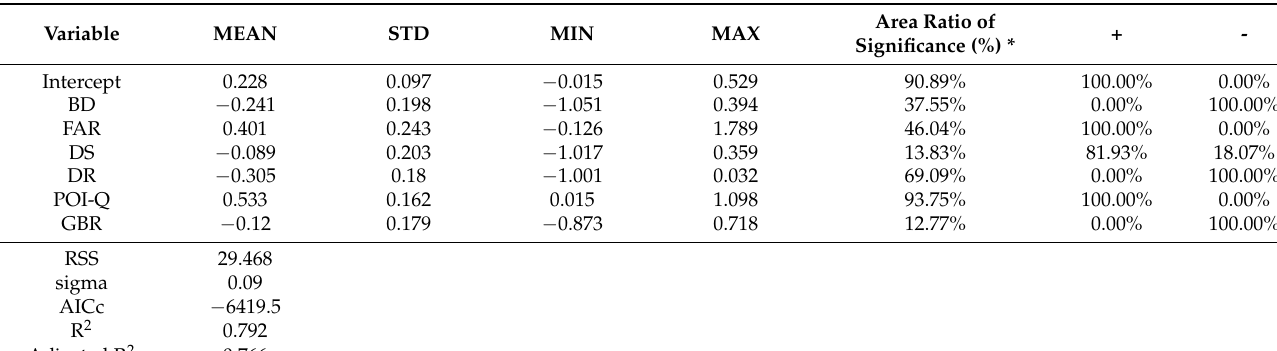
Table 1. The GWR model results for the pre-epidemic period.